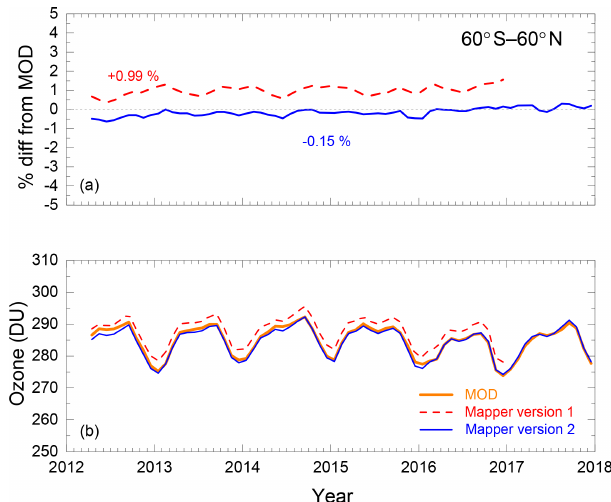
Figure 4. For average ozone in the 60 ◦ S–60 ◦ N latitude zone (b) , the average bias of NM ozone relative to MOD (a) was reduced from 0.99% in version 1 to − 0 . 20% in the version 2 processing.